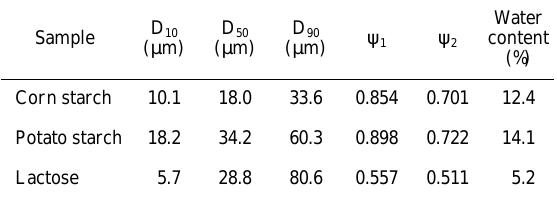
Table 1 Physical Properties of the Samples